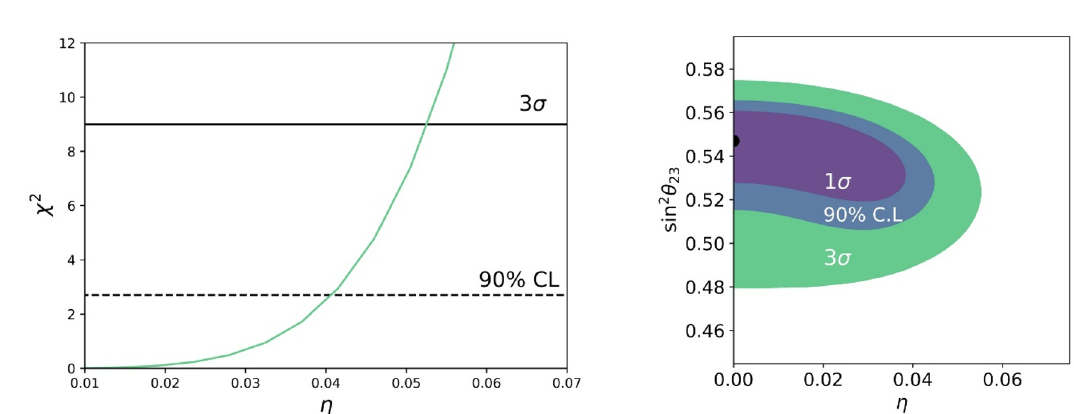
Figure 7 . Left: χ 2 profile as a function of η and confidence levels to discriminate with respect to the standard 3 ν picture. Right: allowed region in the plane ( η, sin 2 θ 23 ) in DUNE. Best fit values chosen for mock data are marked by a black circle (standard oscillations assumed as true